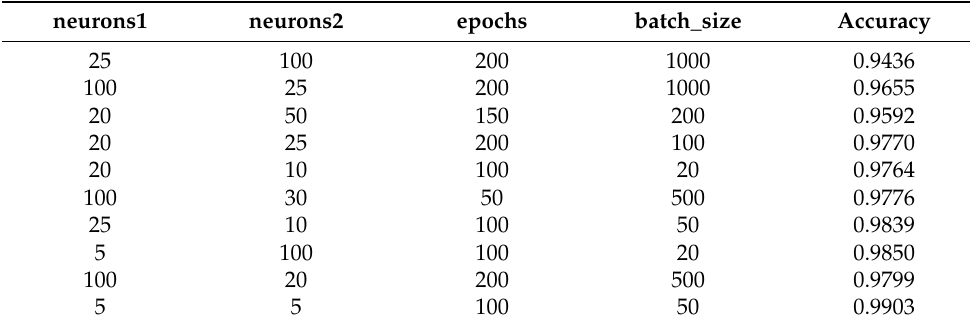
Table 3. Optimization of convolutional layers’ hyper-parameters for the Le-net5.